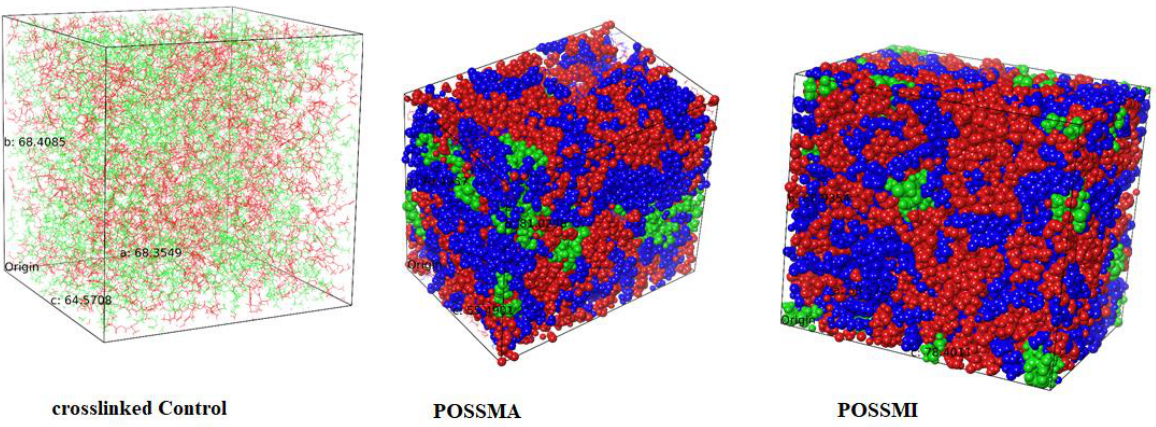
Figure 2. Equilibrated Control (BisGMA-green chains, TEGDMA — red chanins), POSSMA5 and POSSMI5 systems (blue spheres — BisGMA, red spheres — TEGDMA, green spheres — POSS).